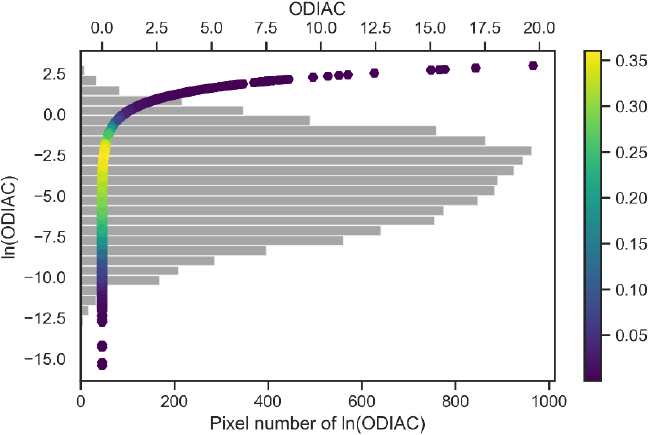
Figure 1. Comparison of the non-zero part of ODIAC data before and after logarithmic transformation in 2014. The x-coordinate of each hexagon points is the ODIAC value of the sample, the y-coordinate is the natural logarithm of the sample, and the color shows the kernel density calculated by the Gaussian kernel. The gray histogram shows the quantity distribution after logarithmic trans- formation.